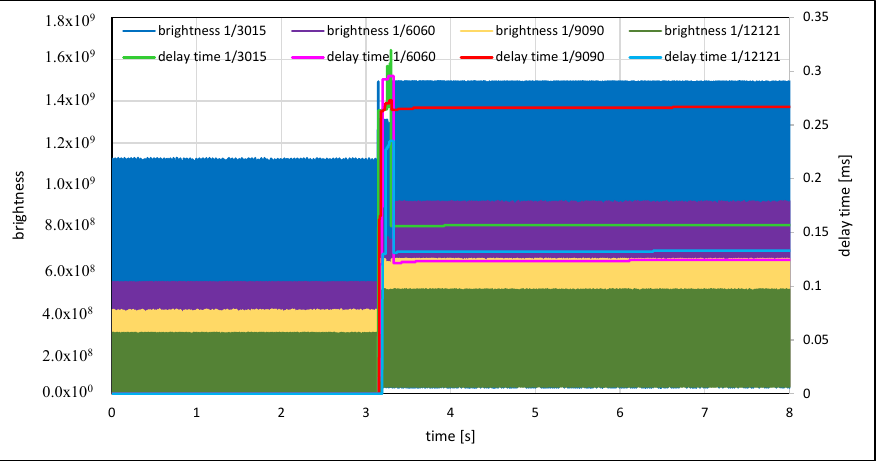
Figure 8. Relationship between total brightness and delay when 3000 fps black-and-white projection is captured at different exposures.